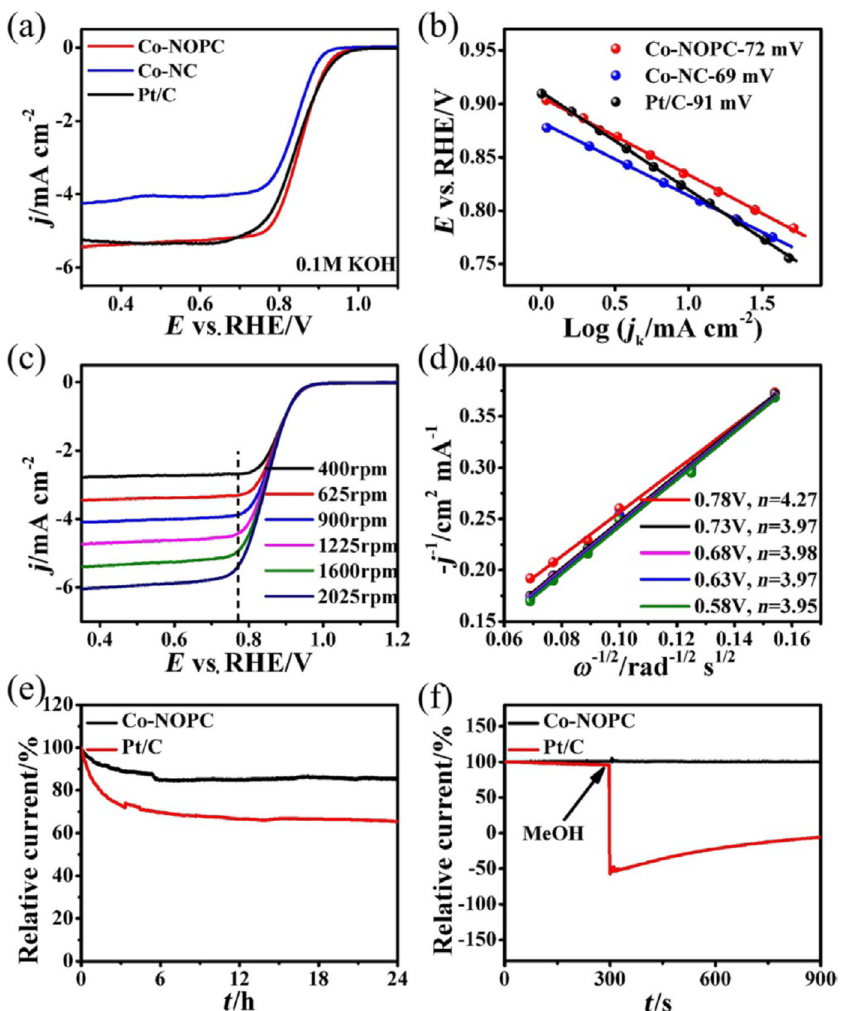
Figure 13. ( a ) ORR polarization curves and ( b ) the correspondinf Tafel plots. ( c ) LSV curves of the MOF-based catalyst (denoted Co-NOPC) at different rotating speeds and ( d ) the corresponding Koutecky–Levich (K-L) plots. ( e ) Chronoamperometric and ( f ) methanol-crossover chronoamperometric responses for Co-NOPC and Pt/C. All tests were performed in 0.1 M KOH. Reprinted with permission from reference [99]. Copyright (2020) John Wiley and Sons.